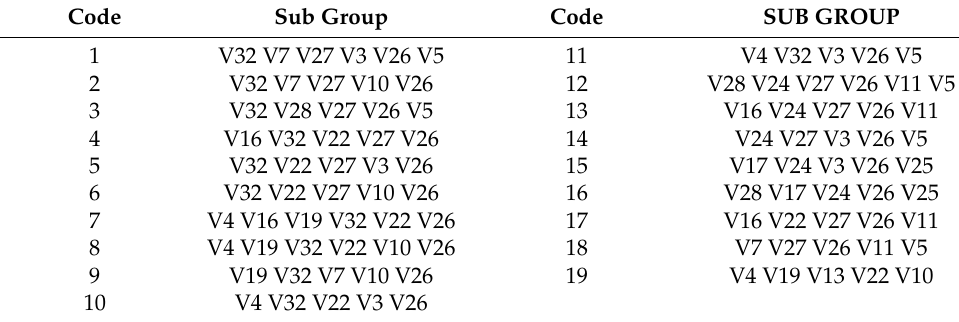
Table 6. Factional analysis of the